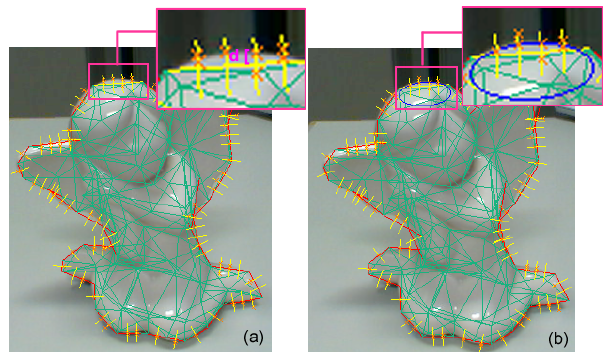
Fig. 2. (a) When the edges from the mesh are used alone with sparse meshes, a large distance d between the sample points on the model and the detected edge points is evaluated. (b) However, by approximating each patch by a quadric surface, its projection represented by conic curves (blue line) approximates better the object outline - the conic curve shape is very close to the object outline in the highlighted part.